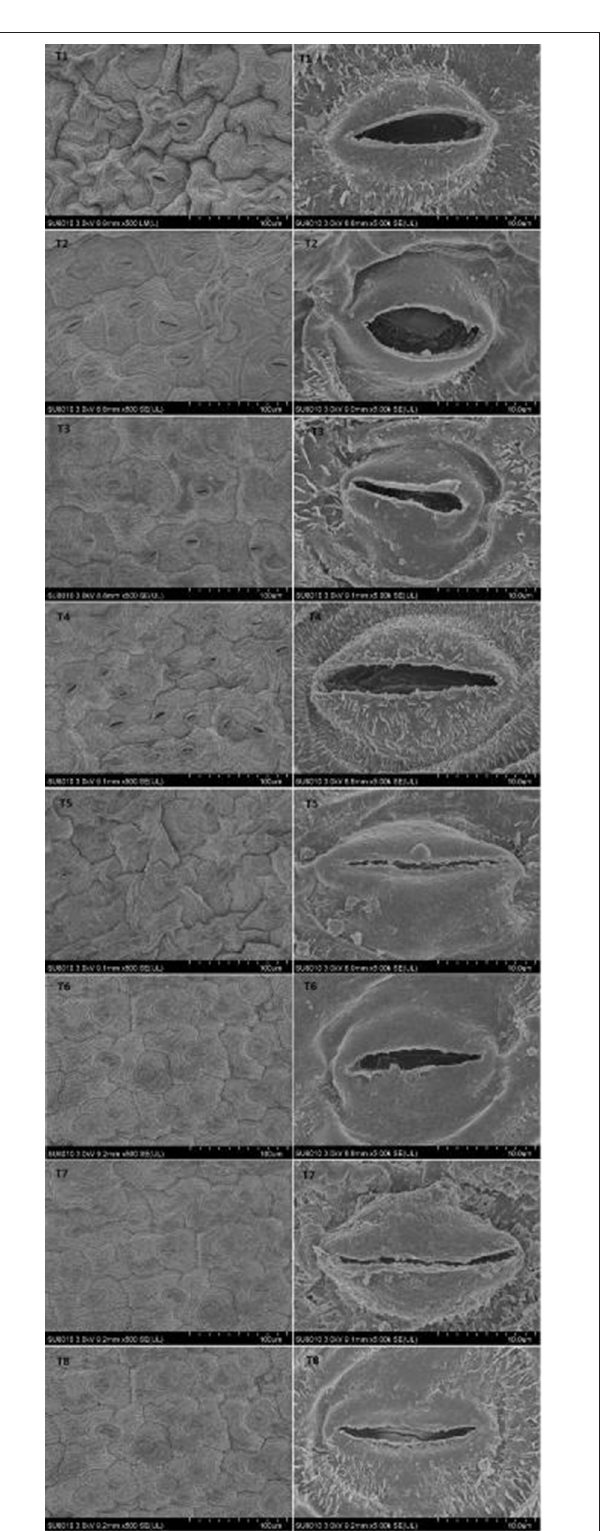
FIGURE 6 | Effects of SA on stomatal structure of D . superbus grown under salt stress (means ± SD ).